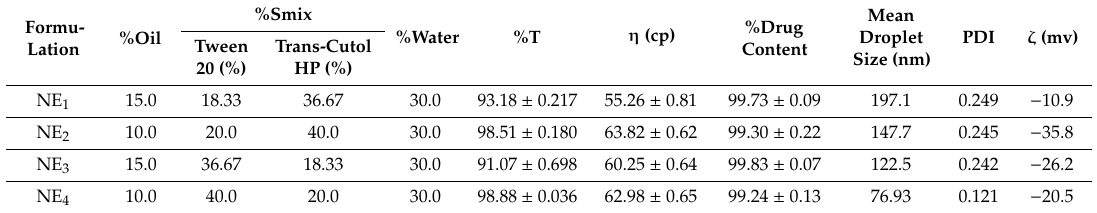
Table 1. Composition and characterization of di ff erent imiquimod nanoemulsions (IMQ-NE). Formu-